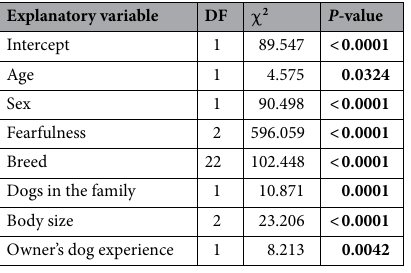
Table 1. Association between the explanatory variables and aggressive behaviour in the logistic regression model. All were a priori contrasts. Significant ( P < 0.05) associations are emboldened. N = 9270.